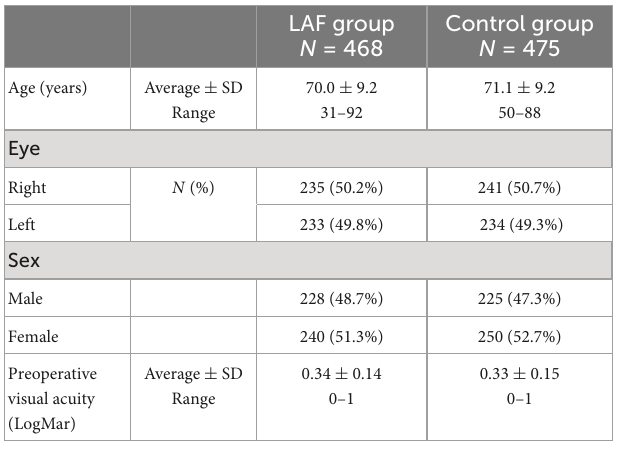
TABLE 1 Patient baseline characteristics, including age, laterality, sex, and preoperative visual